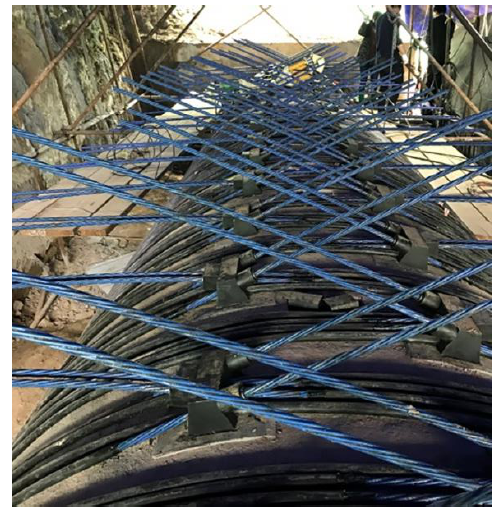
Figure 19. A spot photo of the test pipe after tensioning.